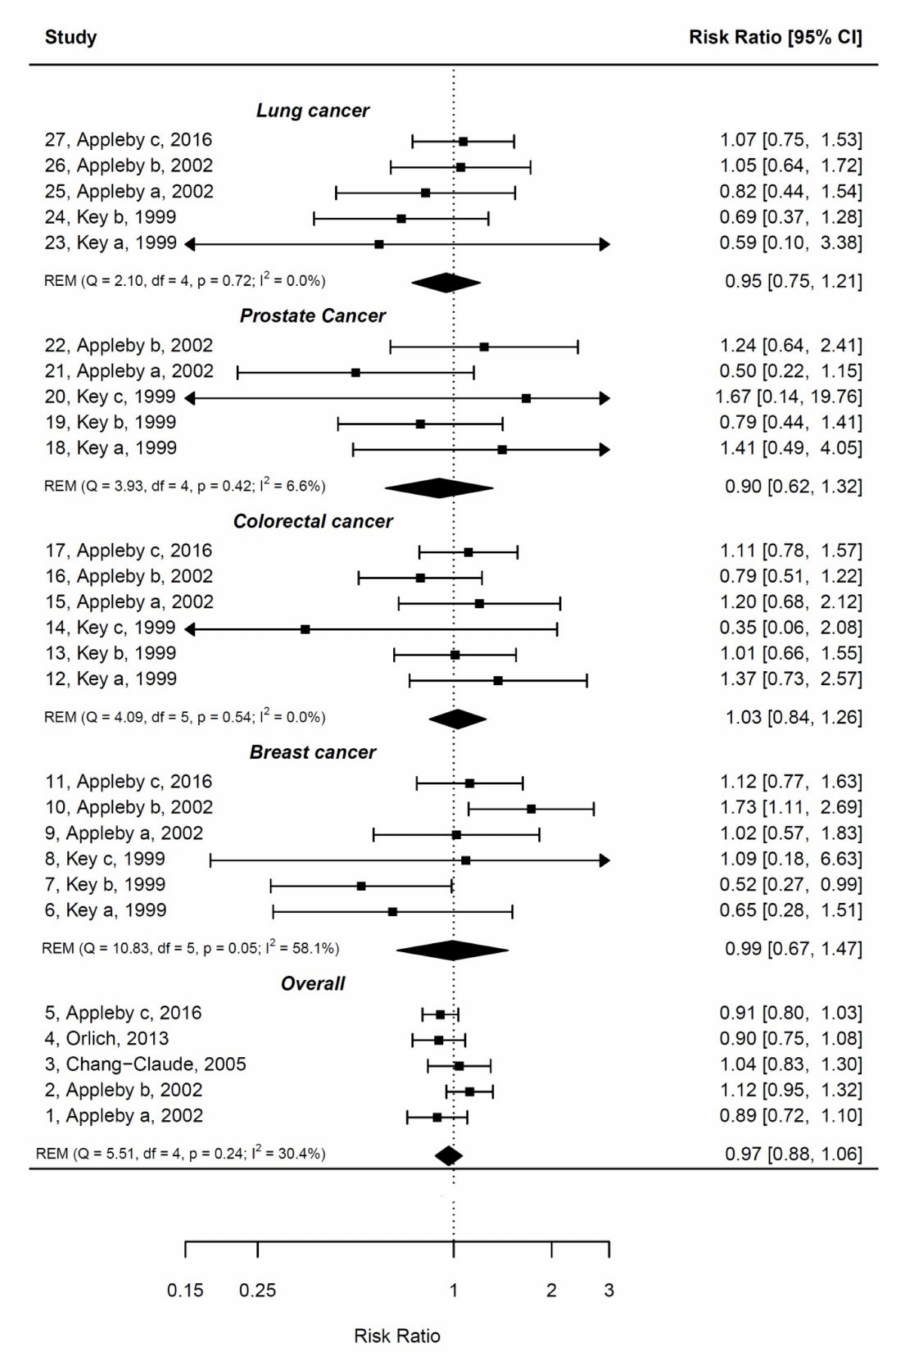
Figure 1. Meta-analysis under random-e ff ects model (REM) with regard to vegetarian diet (VD) (vs. nonvegetarian diet) by subgroups of overall cancer mortality and cause-specific mortality. Q and I 2 statistics are indicated for each subgroup analysis together with the pooled estimate